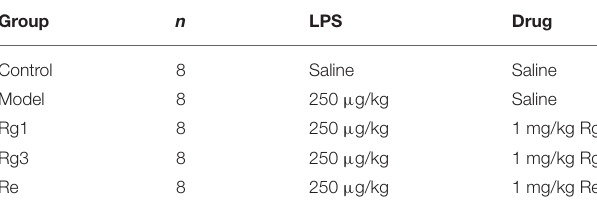
TABLE 1 | Experimental design (experiment 1).